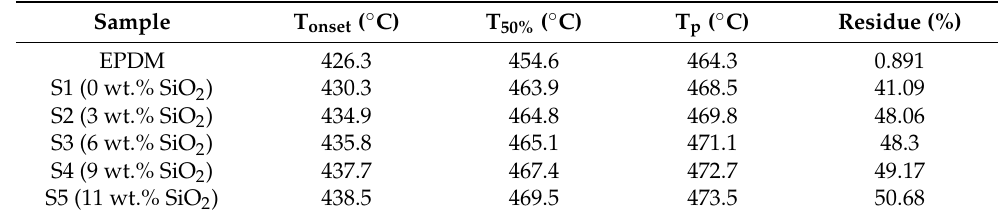
Figure 3. TGA curves of EPDM silica and EPDM-based MREs with different contents of silica. Table 1. Thermal decomposition temperatures of EPDM, silica and EPDM-based MRE